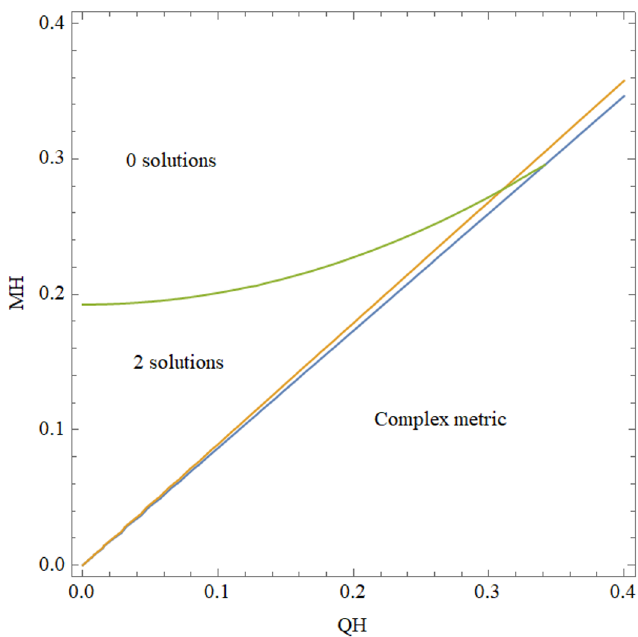
JHEP11(2021)058 √ 3 , here illustrated by the value α = 1 / 2 . The green Figure 4 . Number of horizons for α < 1 / curve represents F ( r ) = 0 and gives an upper bound on the mass. The yellow line represents 0+ √ 3 . The blue one is Q 2 = (1 + α 2 ) M 2 , that does not play anymore the same role for α < 1 / Q 2 = M 2 / (1 − α 2 ) . In the region between the green and the blue curves, cosmological and event horizons are present. Below the blue one, r , r and the metric become complex + −